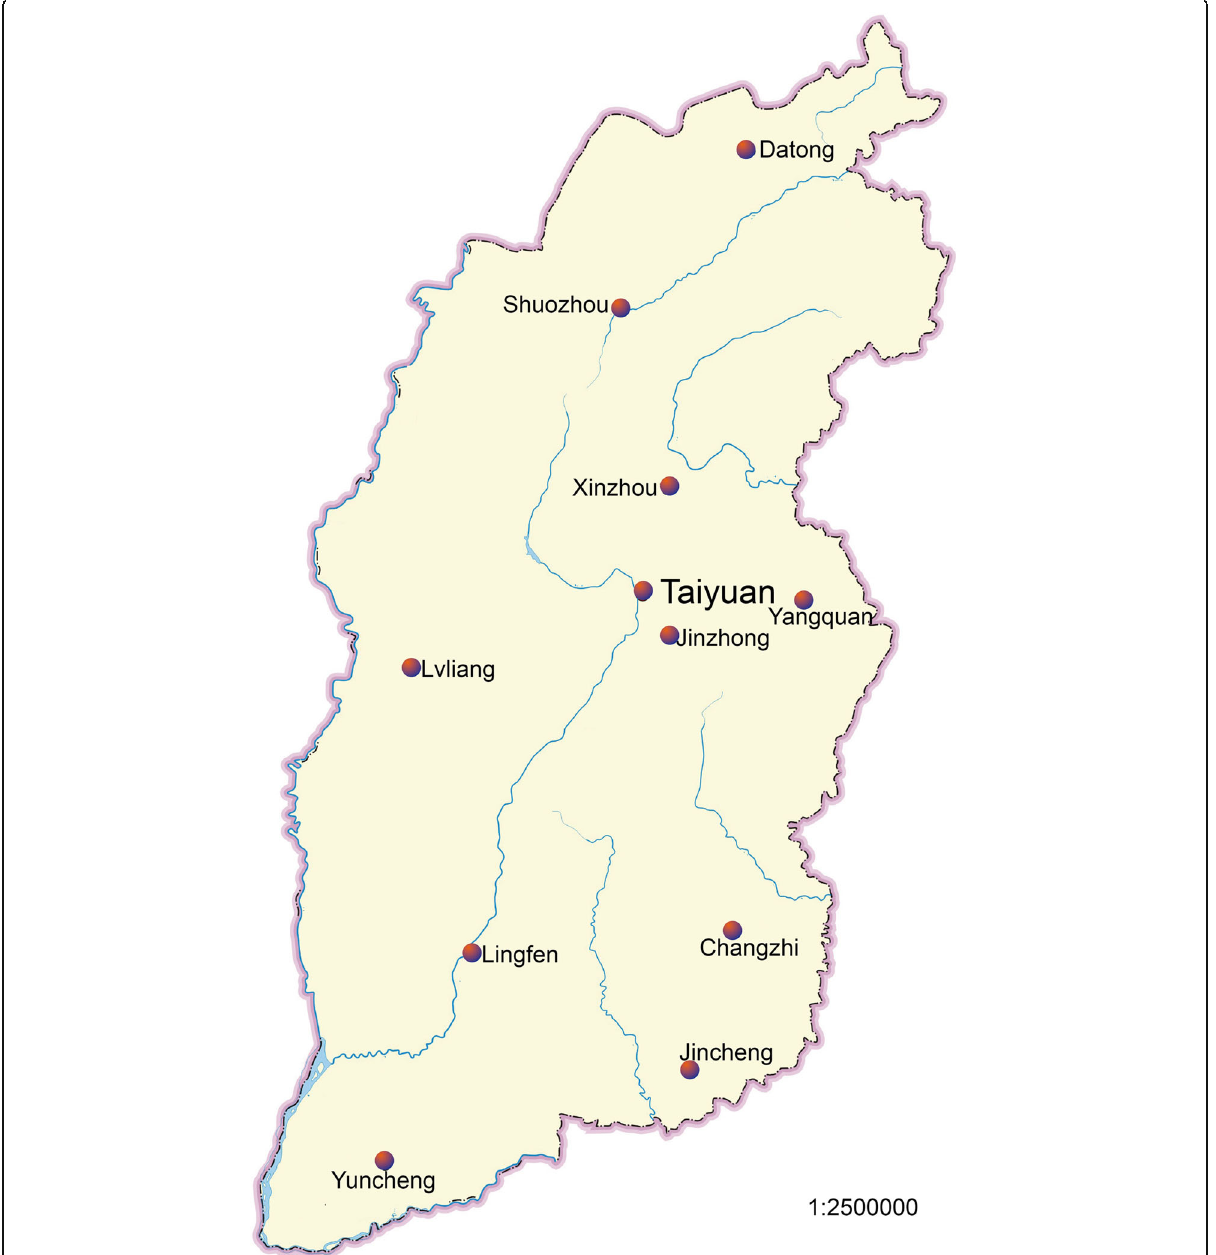
Fig. 1 Geographical distribution of PCV3 in Shanxi Province, China (censor code of this map: GS (2019) 3333). Red dots represent the regions with PCV3 positive